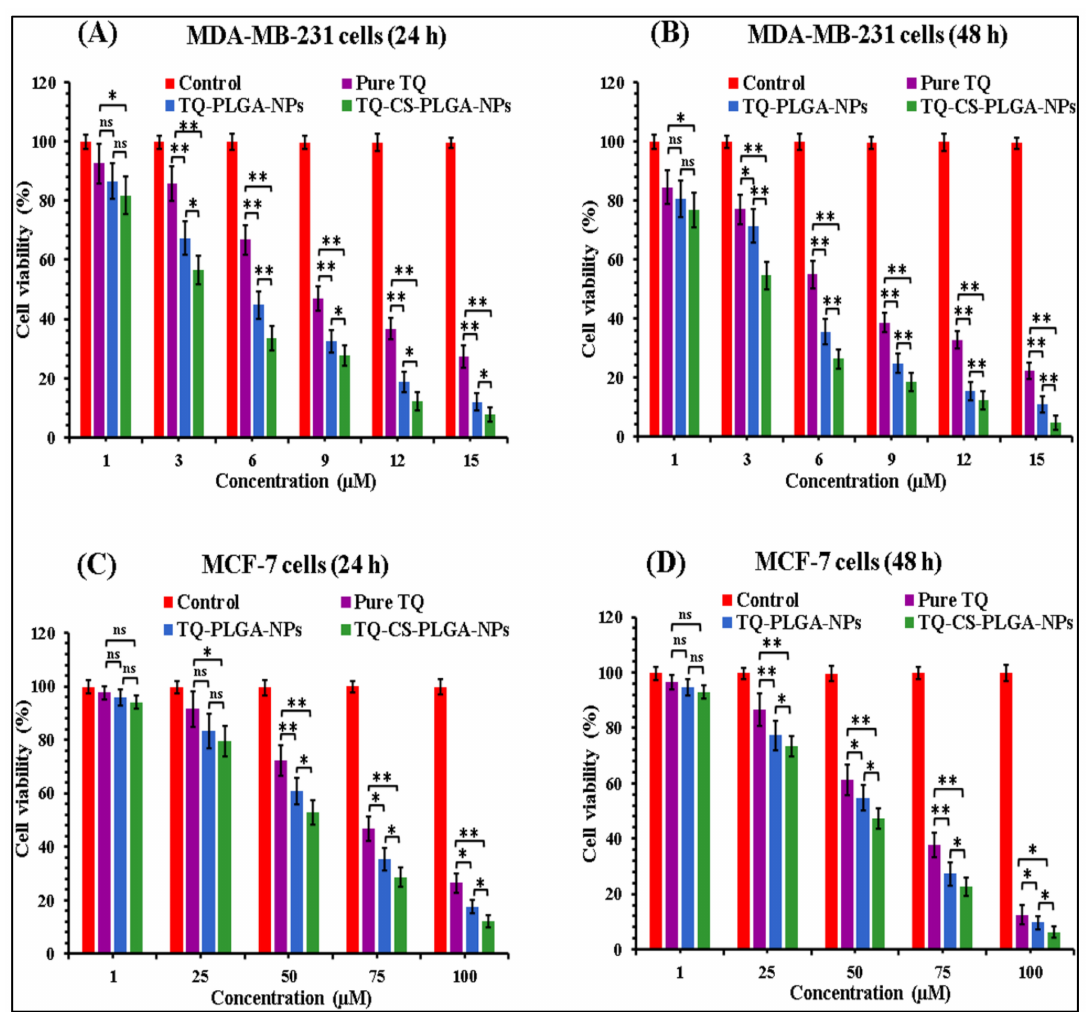
Figure 8. Comparative cytotoxicity study of TQ-Cs-PLGA-NPs, TQ-PLGA-NPs, and pure TQ against ( A ) MDA-MB-231 cells after 24 h; ( B ) MDA-MB-231 cells after 48 h; ( C ) MCF-7 cells after 24 h; ( D ) MCF-7 cells after 48 h. Results are expressed as percentage mean ± SD ( n = 3), * and ** represent significant and highly significant difference to different